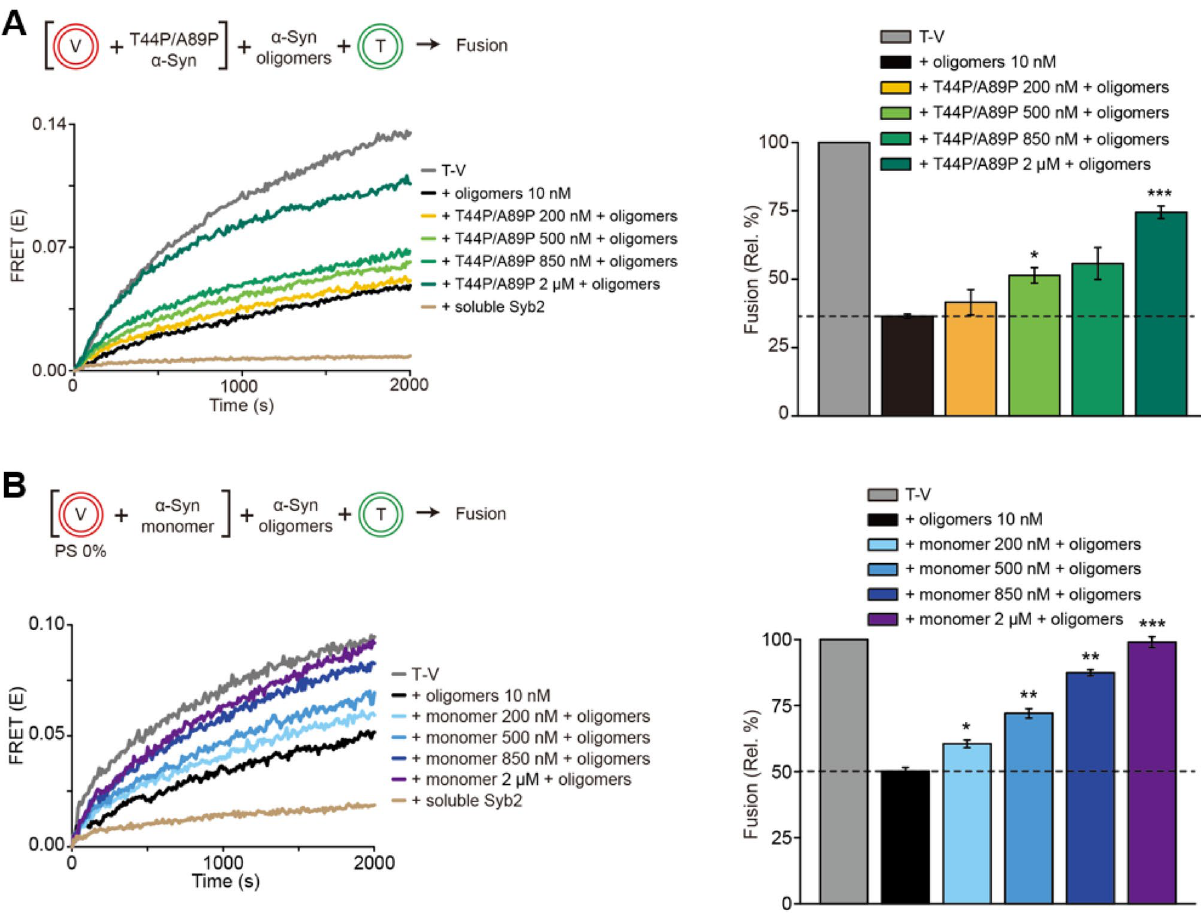
Figure 3. α-Syn monomer interactions with the lipid membrane enable cooperative inhibition of vesicle fusion. ( A ) The effect of the lipid-binding-deficient mutant of the α-Syn monomer (T44P/A89P) on fusion inhibition. v-Vesicles (V) were incubated with the T44P/A89P monomer for 10 min, and then α-Syn oligomers and t-vesicles (T) were added to the premixture. T and V (20 μM lipid concentration) were mixed together at 37 °C without α-Syn (T-V, gray line). Fusion efficiency was significantly reduced by the addition of α-Syn oligomers (10 nM, the black line). When the T44P/A89P α-Syn monomer was added to the T–V mixture together with oligomers, the FRET signal increased (200 nM, yellow line; 500 nM, light green line; 850 nM, green line; 2 μM, dark green line). A control measurement using soluble Syb2 confirmed that lipid mixing was driven by SNARE complex formation (beige line). Bar graphs were obtained from the values at 2000s from the FRET measurements (± SEM, N = 3). *P < 0.05, **P < 0.01, ***P < 0.001 by Student’s t test. ( B ) The effect of the negatively charged lipid (PS) on fusion inhibition. v-Vesicles (V) prepared with 0% PS were used in the measurement. v-Vesicles without PS were incubated with wild-type α-Syn monomer, and then t-vesicles (T) and oligomers were added to the premixture. The gray and black lines denote the T–V mixture and the T–V mixture with α-Syn oligomers, respectively. When wild-type α-Syn monomer was added to the T–V mixtures together with oligomers, the FRET signal increased (200 nM, cyan line; 500 nM, light blue line; 850 nM, navy line; 2 μM, purple line). A control measurement using soluble Syb2 confirmed that lipid mixing was driven by SNARE complex formation (the beige line). Bar graphs were obtained from the values at 2000s from the FRET measurements (± SEM, N = 3). *P < 0.05, **P < 0.01, ***P < 0.001 by Student’s t test. All graphs were produced using OriginLab 8.5 software (OriginLab Corporation) and edited by Adobe Illustrator CS6